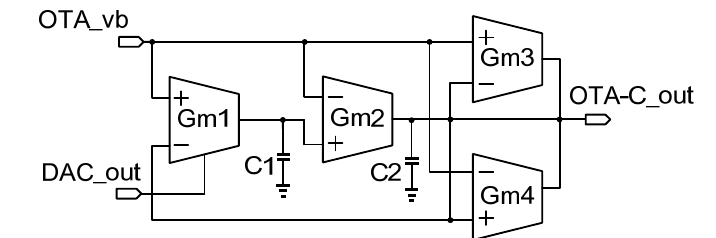
Figure 12. Schematic of the OTA-C